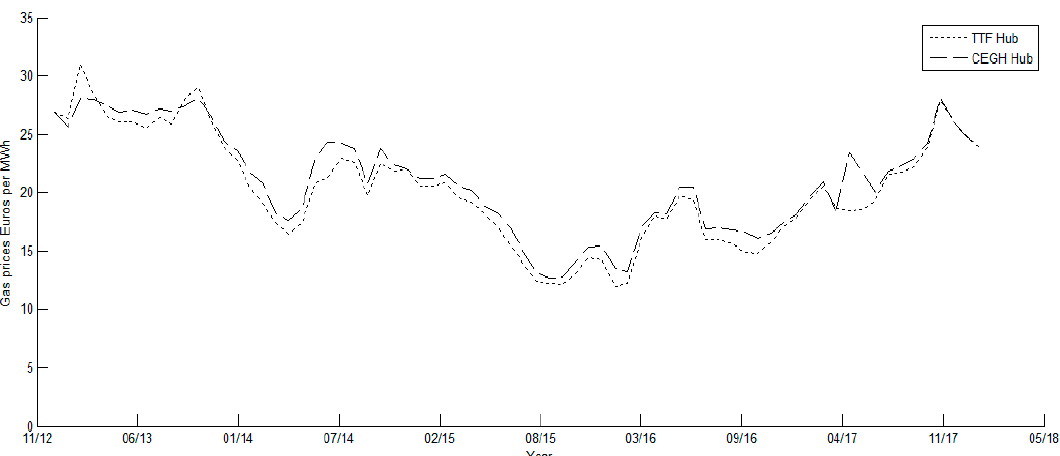
Figure 3. Monthly gas prices for the two gas hubs, Euros/MWh (available upon request for research students from market and information services at the European Energy Exchange, marketdata@eex.com.).